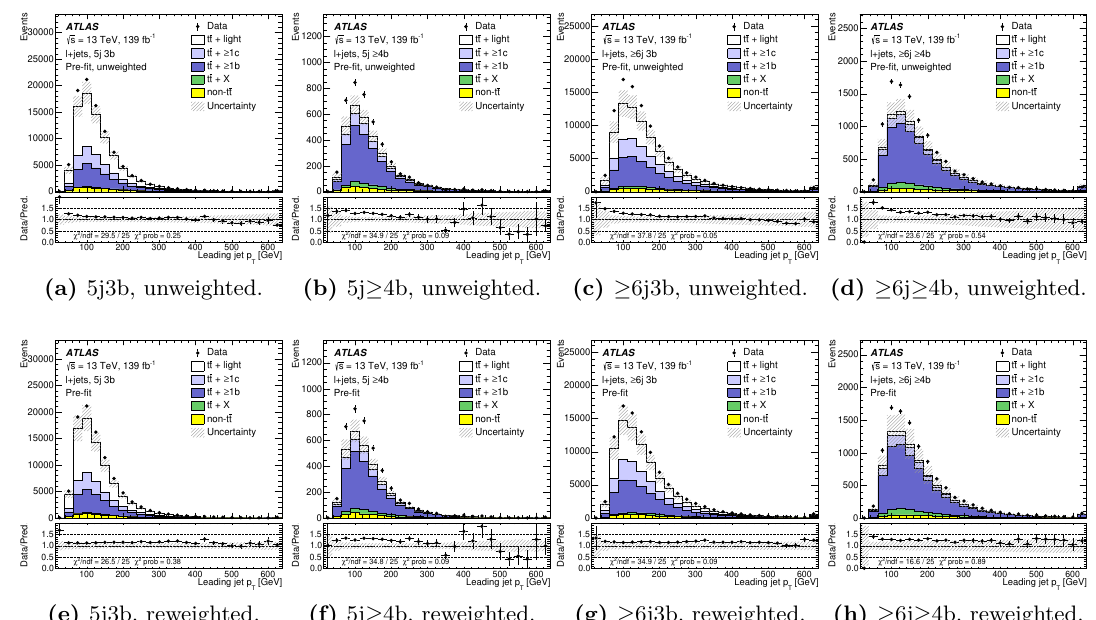
Figure 3 . Comparison of the predicted leading jet p T and data before the fit in the four analysis re- gions before (top) and after (bottom) the reweighting was applied. The uncertainty bands include both the statistical and systematic uncertainties. Since the normalisations of the t ¯ t + ≥ 1 b and t ¯ t + ≥ 1 c backgrounds are allowed to vary in the fit, no cross-section uncertainties associated with these processes are included. The lower panels display the ratio of the data to the total prediction. The hatched bands show the uncertainties before the fit to the data, which are dominated by sys- tematic uncertainties. The χ 2 / ndf and the χ 2 probability are also shown. Statistical uncertainties on MC predictions and data are uncorrelated across bins, while systematic uncertainties on the predictions are